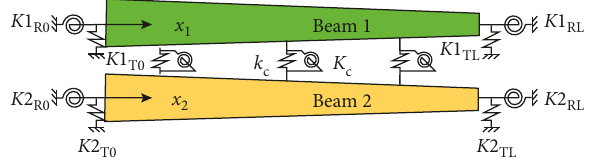
Figure 1: Nonuniform double-beam system with arbitrary boundary conditions, in which both the translational and rotational coupling effects are taken into